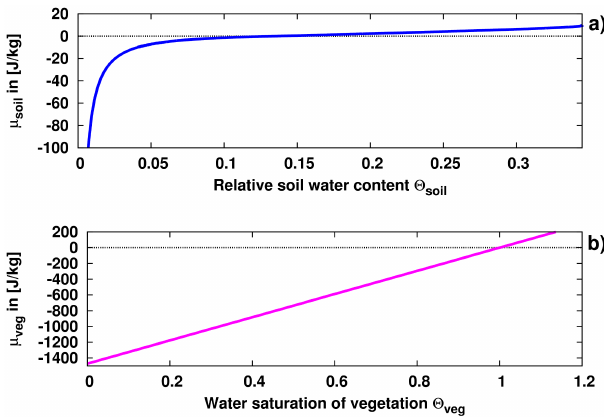
Fig. 3. (a) Soil water potential µ soil as a function of relative water Fig. 24. a) Soil water potential µ soil as a function of relative water content of the soil, 2 soil and (b) vegetation water potential µ veg as content of the soil, Θ soil and b) vegetation water potential µ veg as a function of the water saturation of the vegetation, 2 veg a function of the water saturation of the vegetation, Θ veg .